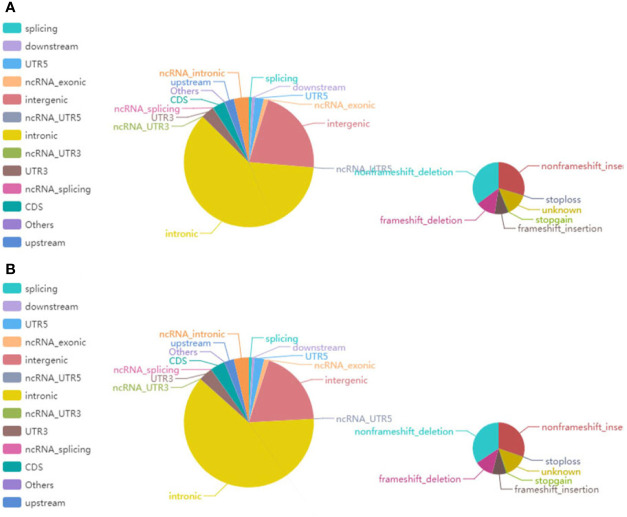
The pie chart represents the distribution of the number of INDELs. (A) The left and right images show the number of INDELs on different regions of the genome and in the coding regions in tumor tissue, respectively. (B) The left and right images reciprocally report the number of INDELs in different regions of the genome and the coding regions in normal tissue.